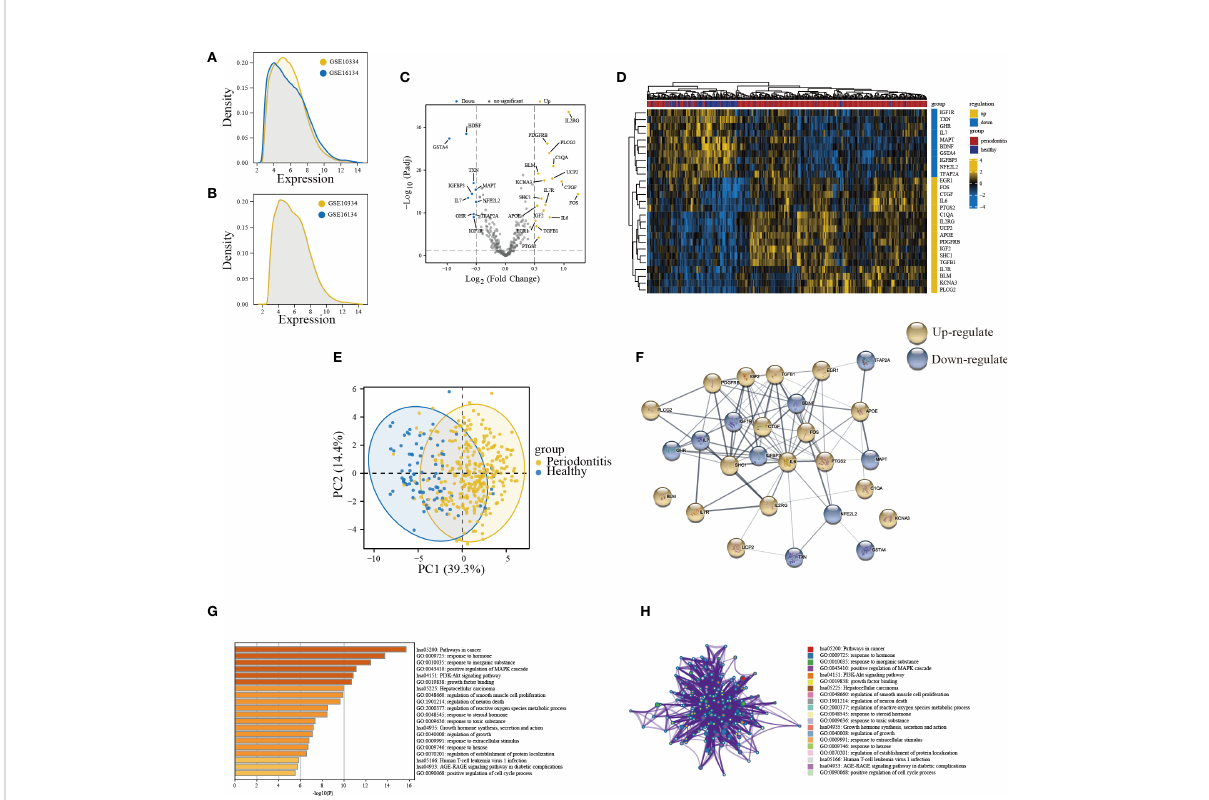
FIGURE 2 Expression patterns and biological signi fi cance of differentially expressed aging-related genes (DE-ARGs) in PD. (A, B) The density of the merge of GSE10334 and GSE16134. (C) Volcano plots visualizing the expression patterns of DE-ARGs in PD and healthy samples. (D) Heatmap of the 27 DE-ARGs in PD and healthy samples. (E) Principal component analysis of the training cohort based on dysregulated aging-related genes. (F) PPI network of proteins encoded by DE-ARGs through the STRING database. (G) Bar graph of enriched terms. The bar was colored by values of p. The lower the values of p, the deeper the color. (H) The network of enriched terms. The top 20 clusters were selected and rendered as a network, in which terms with a similarity score > 0.3 are connected by an edge. The thickness of the edge represents the similarity